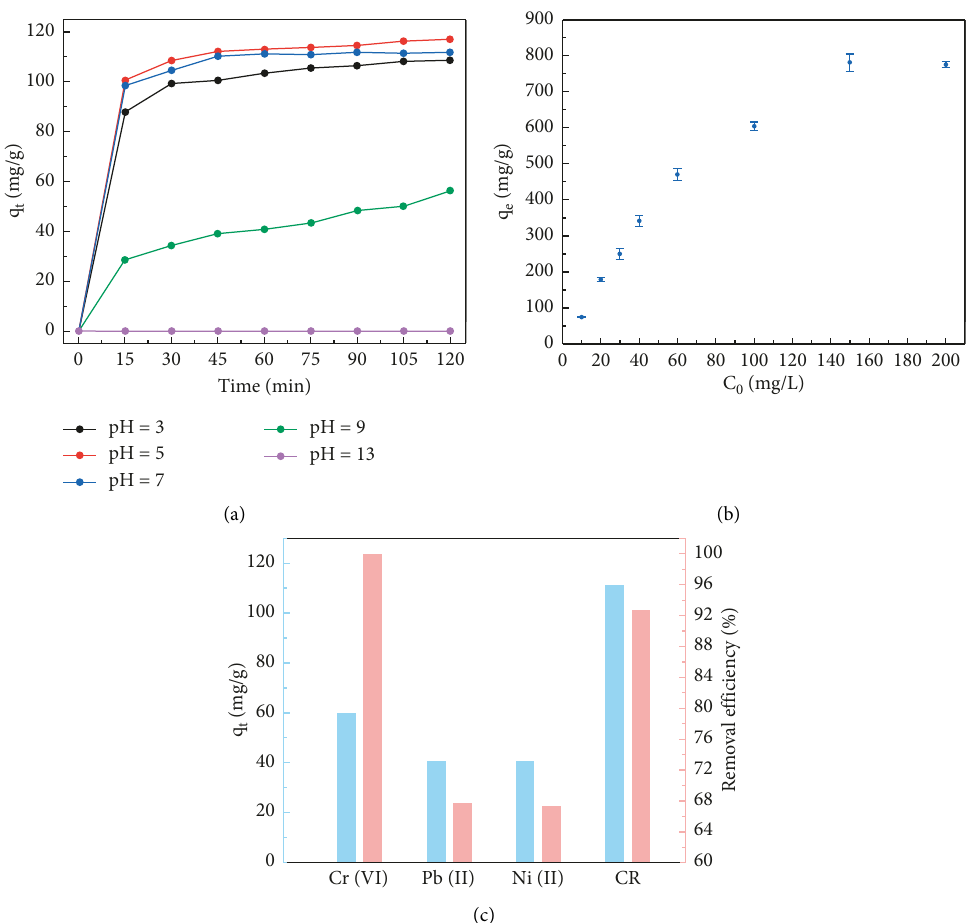
Figure 7: The effect of adsorption capacity for different (a) pH value (30 mg · L − 1 dye, RT), (b) initial dye concentration (RT, pH � 7, t � 90 min), and (c) metal ion (30 mg · L − 1 metal ion, RT, pH � 7, t �